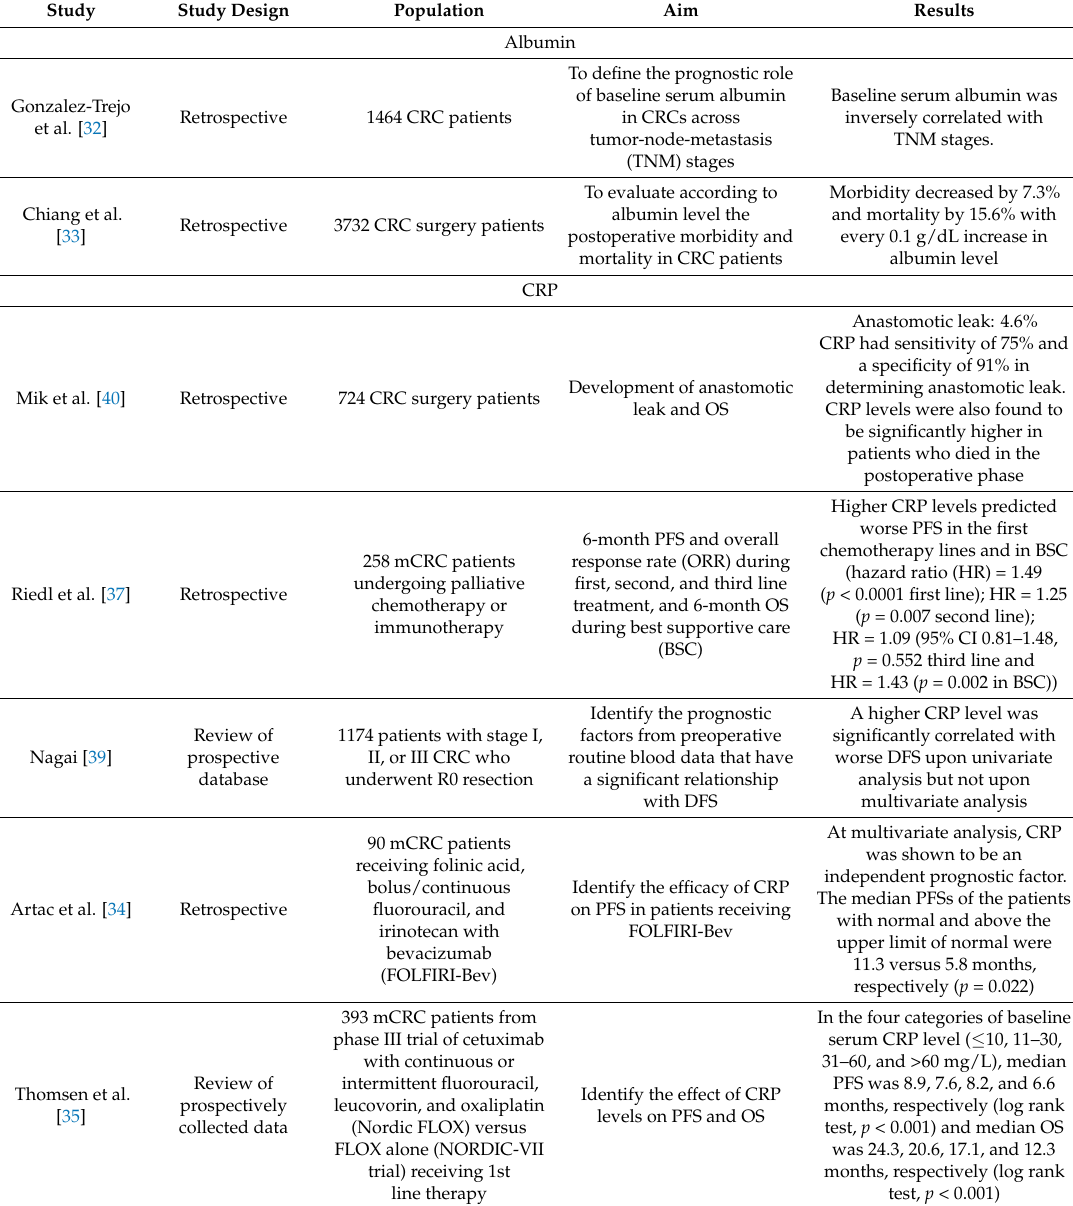
Table 1. Studies evaluating the prognostic impact of acute phase proteins in colorectal cancer